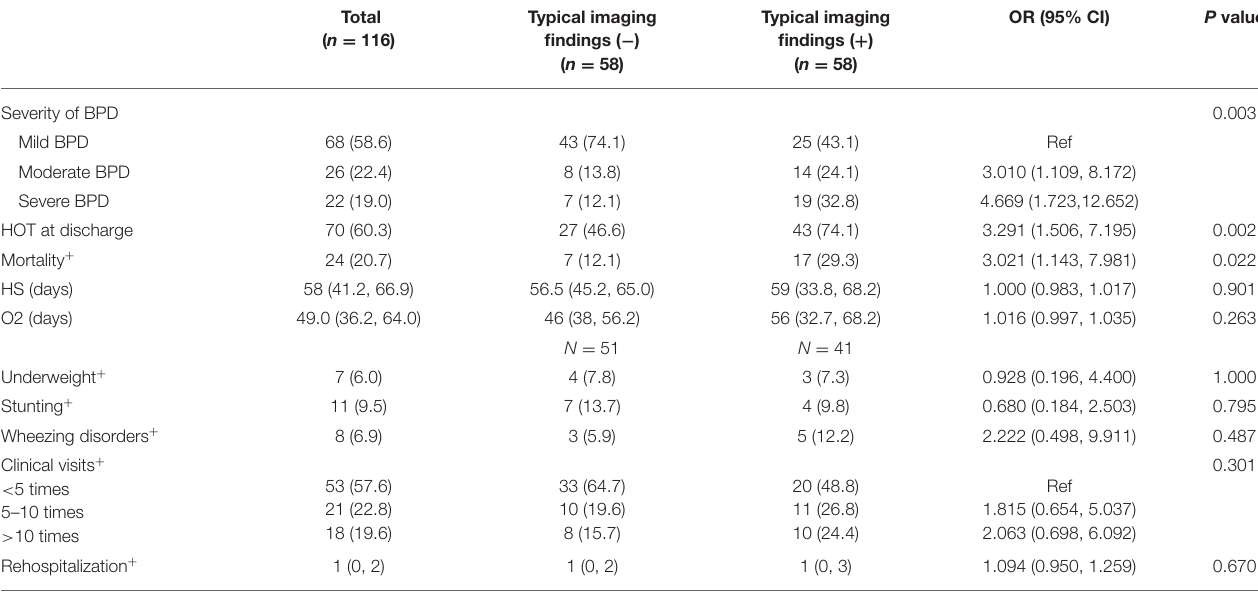
TABLE 2 | Short-term outcomes and follow-up until 2 years of age of preterm infants in the typical imaging finding ( ± ) groups after PSM.